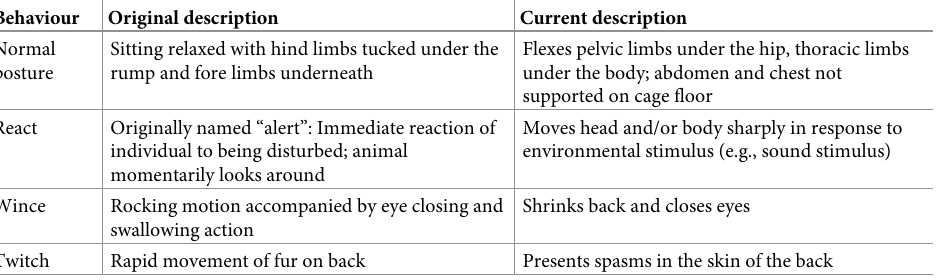
Table 1. Modifications from the original ethogram developed for rabbits submitted to OVH